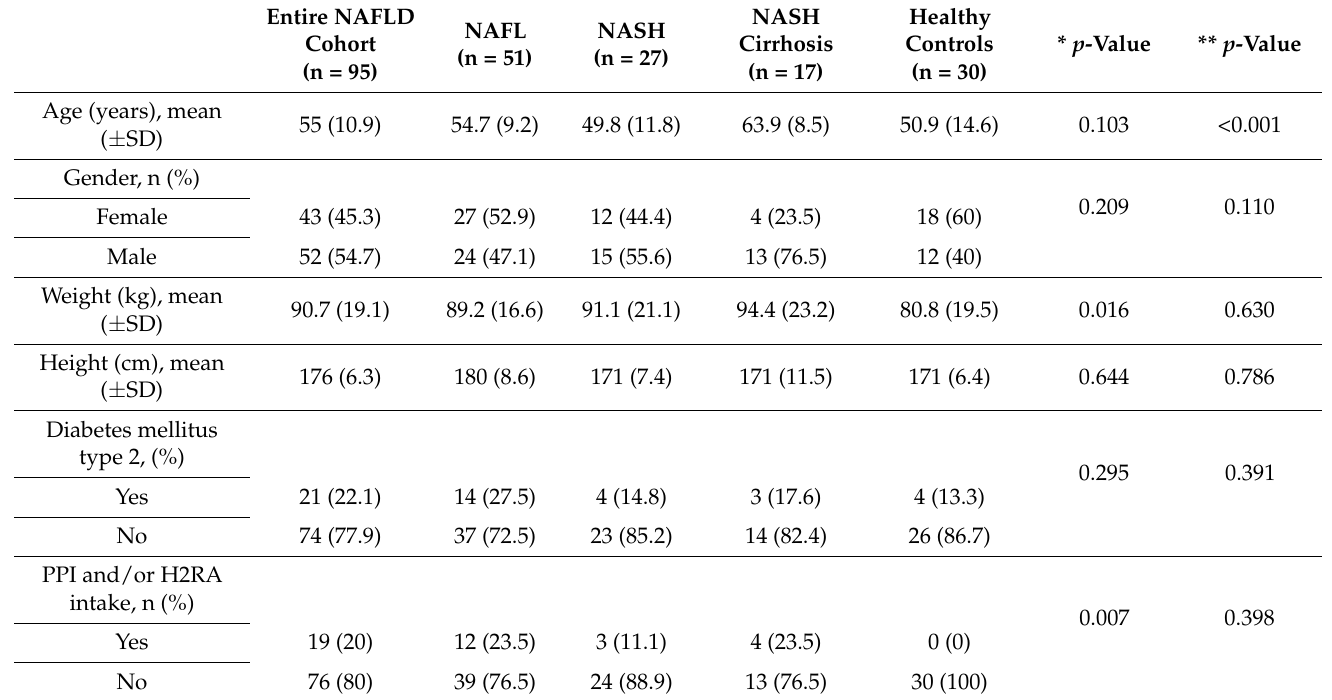
Table 1. Baseline patient